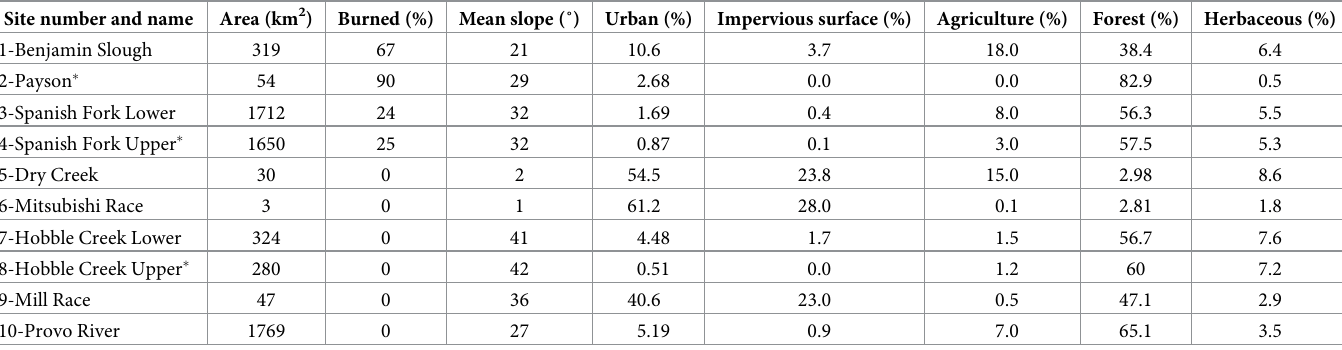
Table 1. Watershed characteristics of sampling sites within the Utah Lake